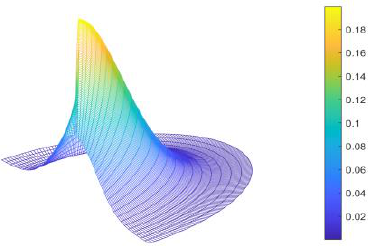
Figure 4. 3D illustration of the initial probability distribution.